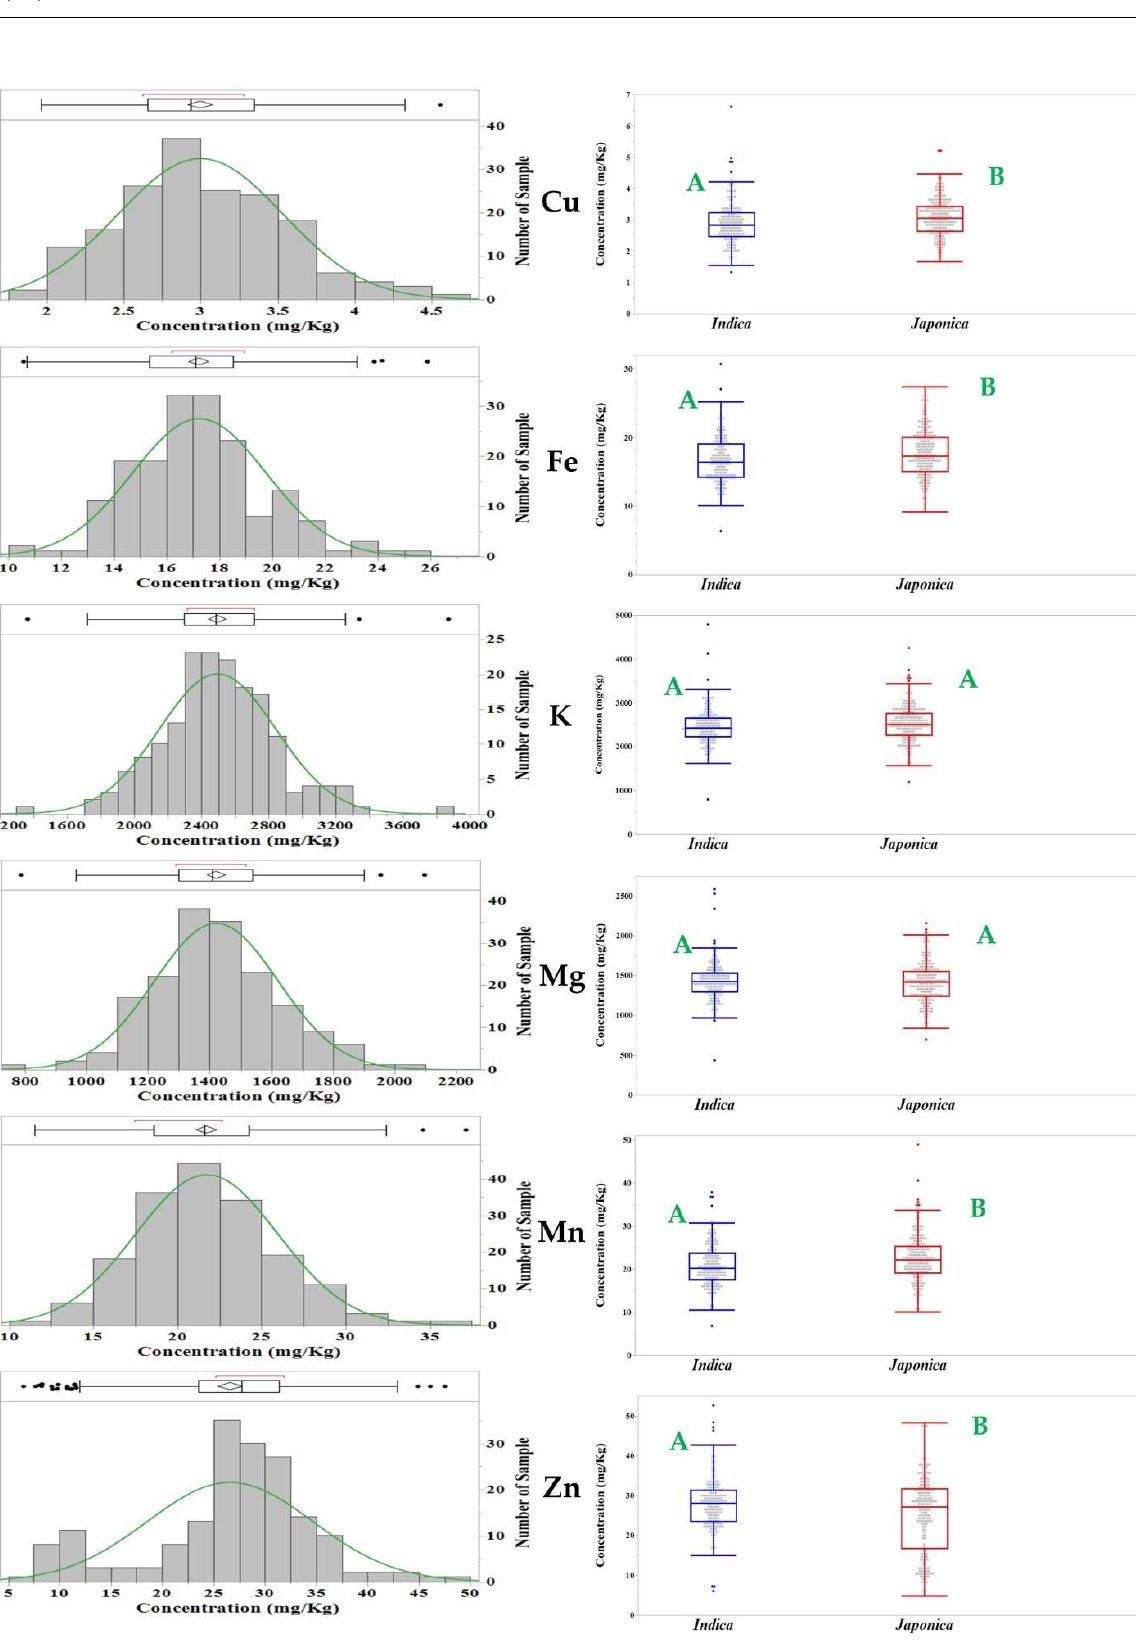
Figure 3. Histogram plots show variation for the concentration of six mineral elements across the rice germplam of this study. Different capital letters (green color) in the box plot indicate that Indica and Japonica rice accessions are significantly different at α= 0.05 for mean value of the six mineral elements.